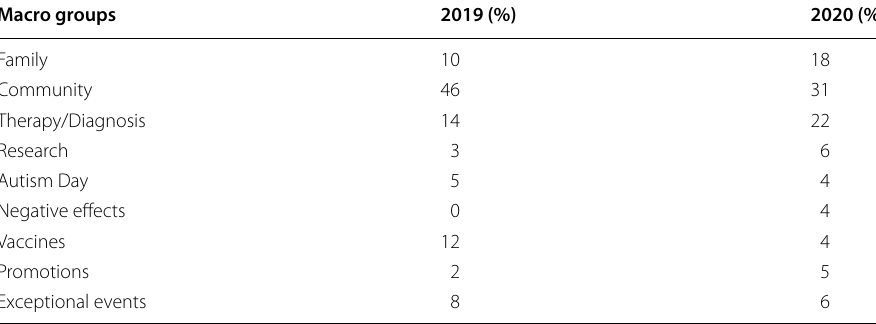
Table 1 Percentage of tweets in macro groups Macro